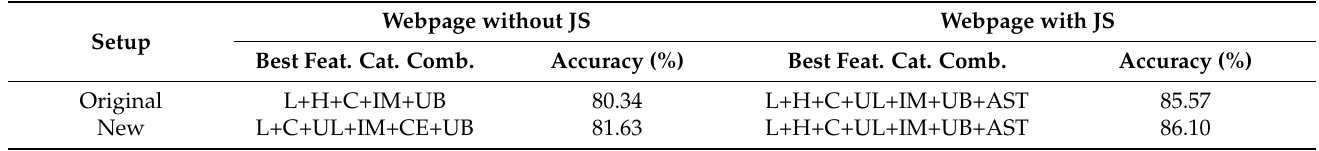
Table 5. Overall performance of the proposed method on webpages that contain JS and those that do not. Webpage without JS Webpage with JS Setup Best Feat. Cat. Comb. Accuracy (%)